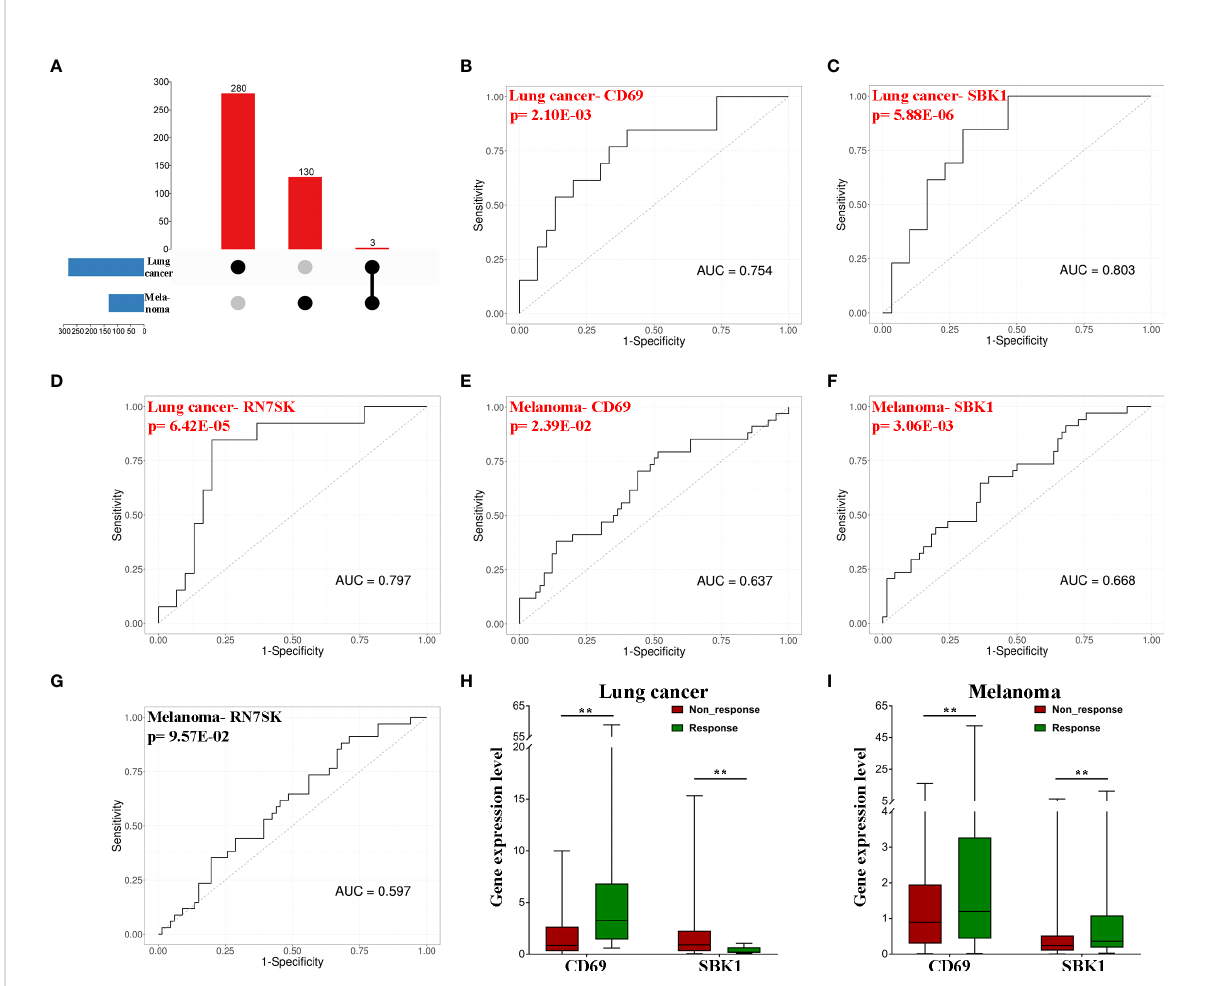
FIGURE 2 CD69 and SBK1 are potential biomarkers of response to PD-1/PD-L1 blockade immunotherapy. (A) Up-set of common genes between lung cancer and melanoma responders. (B – G) Separate ROC analysis of the 3 common genes in lung cancer and melanoma. (H) CD69 (|LogFC| =2.45, adjusted p-value=4.40E-03) is upregulated in lung cancer responders (responders 8.05 ± 4.33, non-response 1.84 ± 0.44), while SBK1 (| LogFC|=2.04, adjusted p-value=1.11E-03) is downregulated (responders 0.39 ± 0.09, non-response 1.80 ± 0.53). (I) both CD69 (|LogFC|=1.63, adjusted p-value=3.04E-03, responders 6.34 ± 2.47, non-response 1.76 ± 0.36) and SBK1 (|LogFC|=1.3, adjusted p-value=7.16E-03, responders 1.26 ± 0.44, non-response 0.51 ± 0.12) are upregulated in melanoma responders. ** indicates